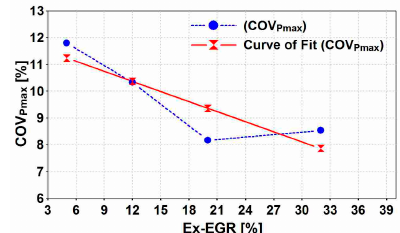
Figure 8. Cyclic variability of P max due to variation of In-EGR setting (rpm = 3000, IMEP = 2.1 bar, T epc = 425 – 530 K).